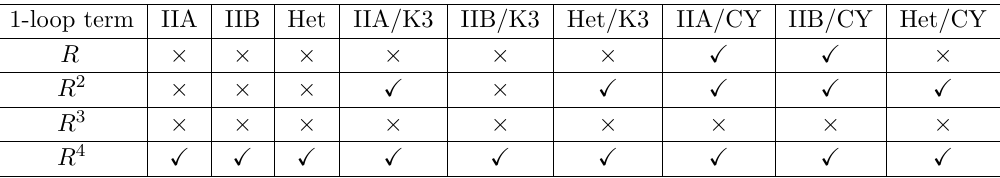
Table 1 . One-loop curvature corrections. The double vertical lines delineate D = 10 ; 6 ; 4. leaves one integration over a puncture, as appropriate for a torus 2-point function with one (cid:12)xed vertex operator. In the (cid:12)eld-theory limit, this string amplitude will indeed generate a 1-mass